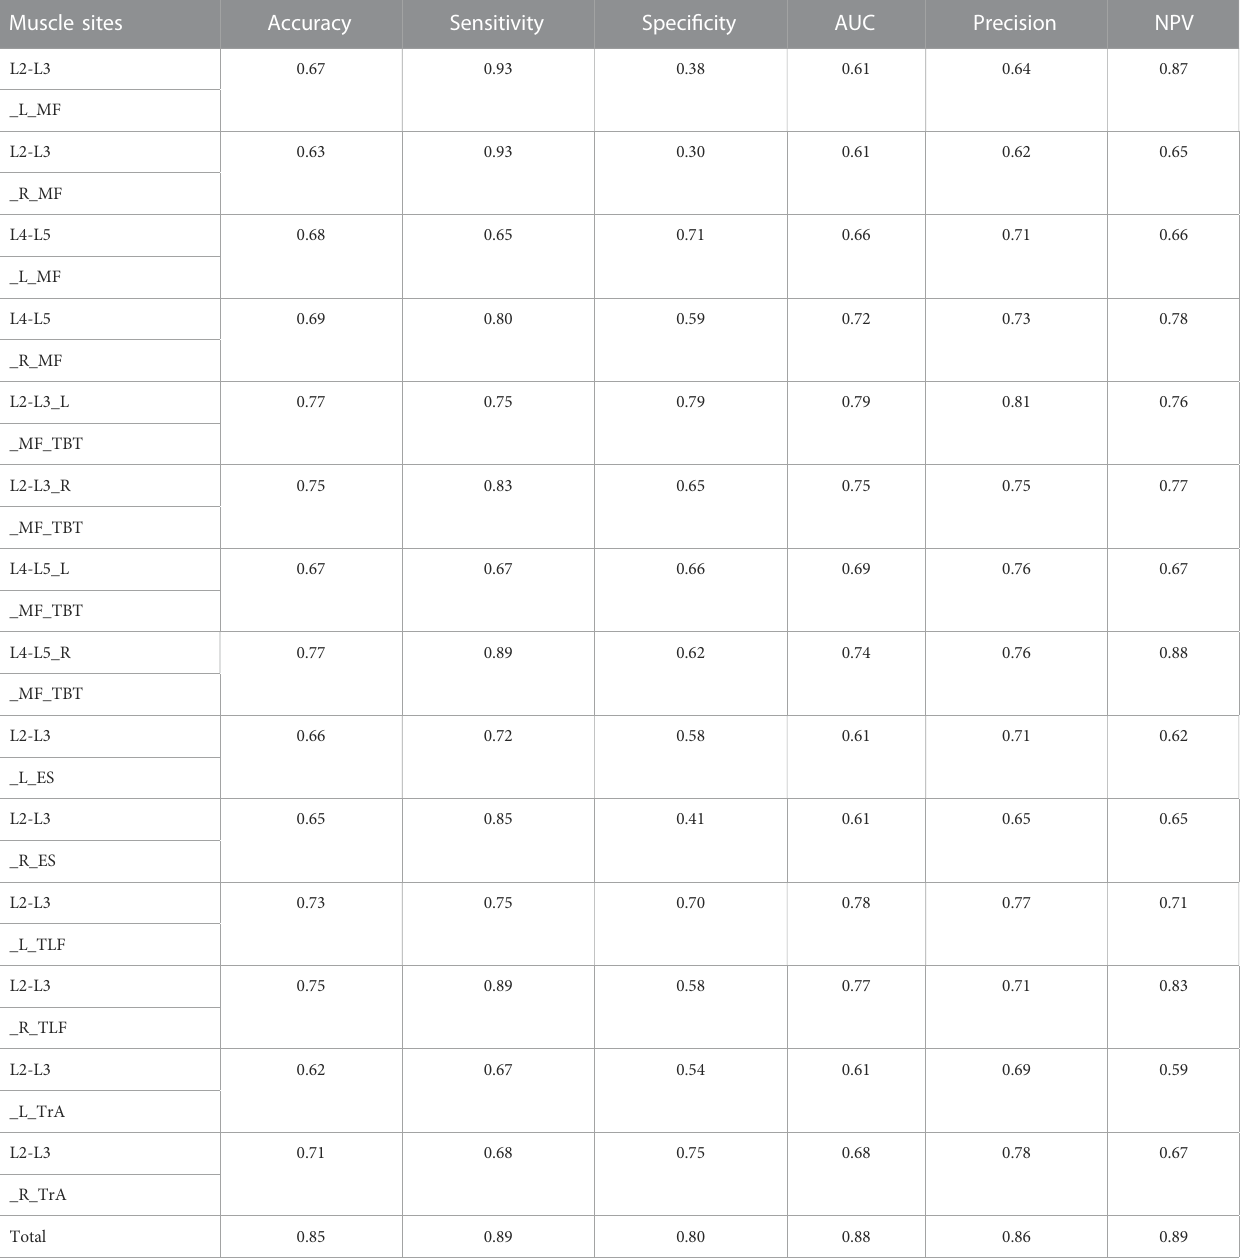
TABLE 9 MIFS framework and SIFS of NSLBP classi fi cation performance. Muscle